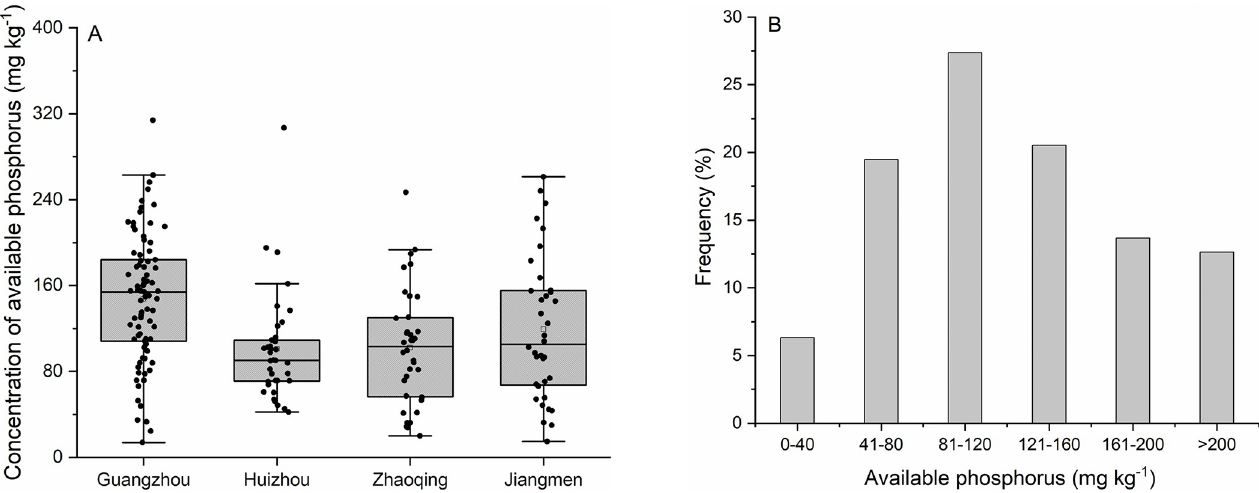
Fig 3. Concentrations (A) and frequency distribution (B) of available phosphorus in studied soils.